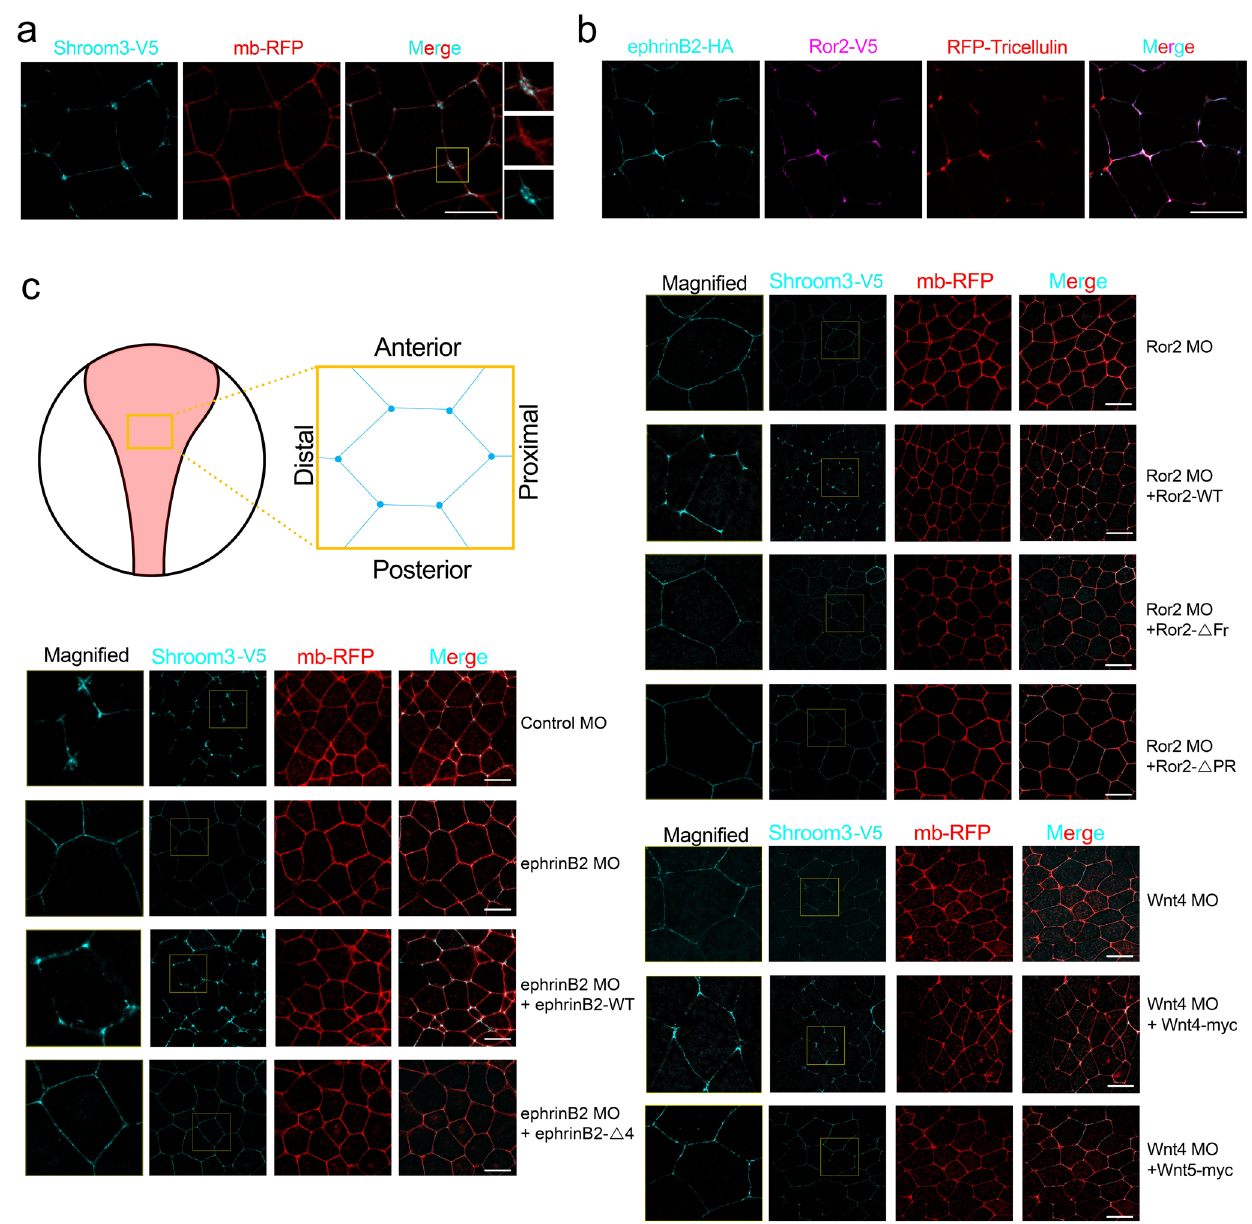
Fig. 5 | EphrinB2 and Ror2 regulate Shroom3 accumulation at tricellular junctions. a Representative images of V5-Shroom3 (100pg) subcellular localiza- tion in neural plate cells in stage 15 embryo. Membrane-RFP (100pg) labeled cell boundaries. The yellow box indicates the magni fi ed area. Scale bar, 10 μ m. b Representative images of ephrinB2 (25pg) and Ror2 (50pg) subcellular